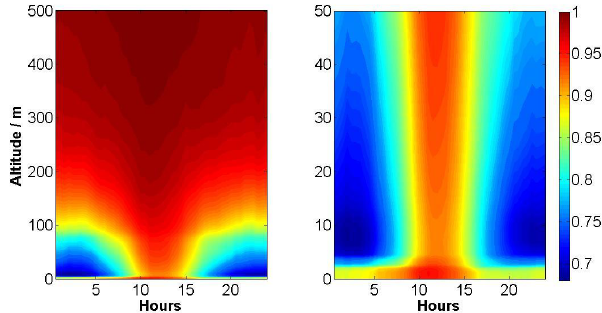
Fig. 11. Yearly average values for 50 and 500m above the surface at SMEAR II for model simulations with the chemistry model from scenario B divided by scenario D (for the definition of the scenarios see Sect. 3.3). The colour bar gives the ratio as described in Eq.